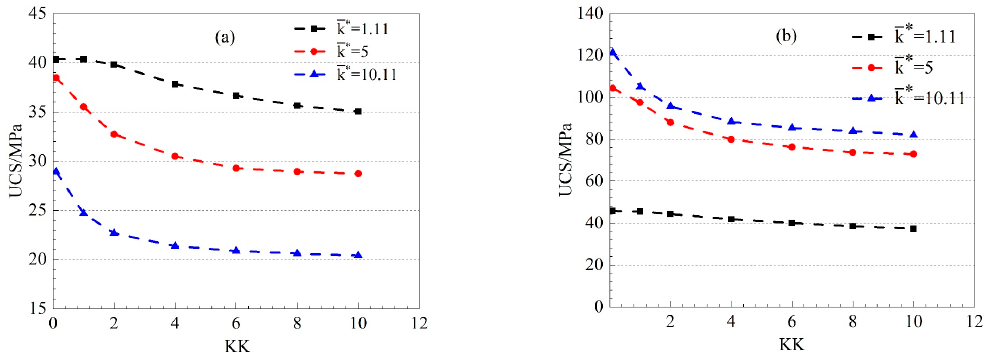
Figure 5. Relationships between bond normal-to-shear stiffness ratio ( coefficient (KK) versus uniaxial compressive strength (UCS). ( a ) σ n / τ n = 0.8, ( b ) σ n / τ n = 4.